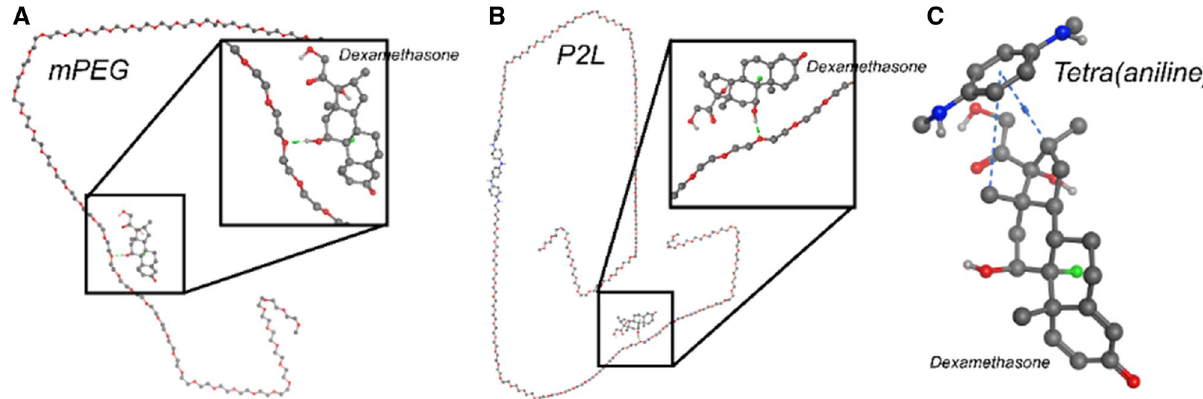
Figure 11. Interaction of P2L with the dexamethasone. The docked conformation of ( A ) dexamethasone and